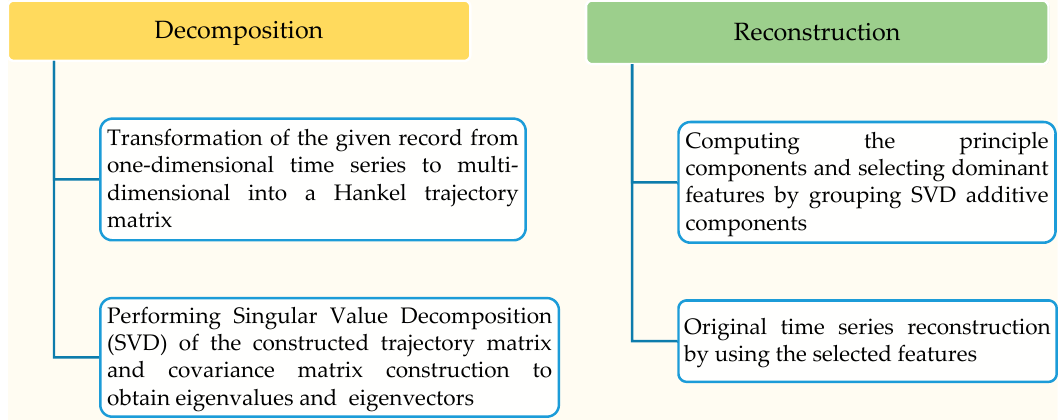
Figure 1. The two complementary stages of the SSA method.